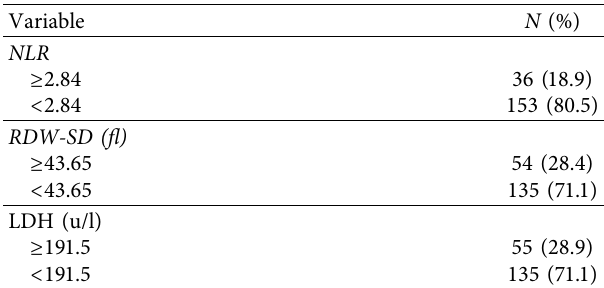
Table 1: Baseline characters of the 190